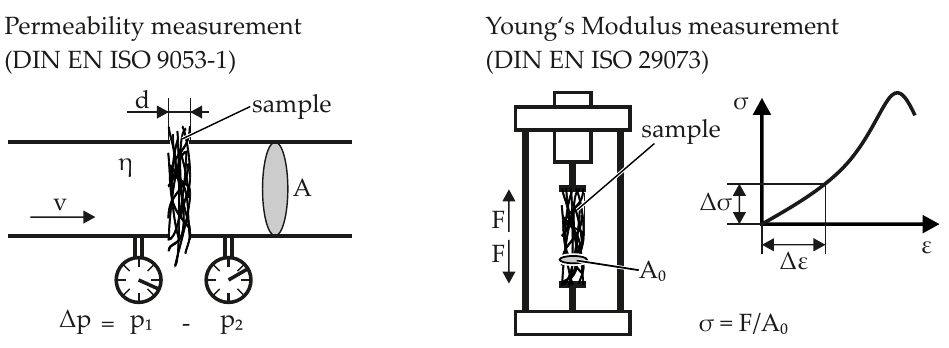
Figure 1. Measurement of permeability and elasticity